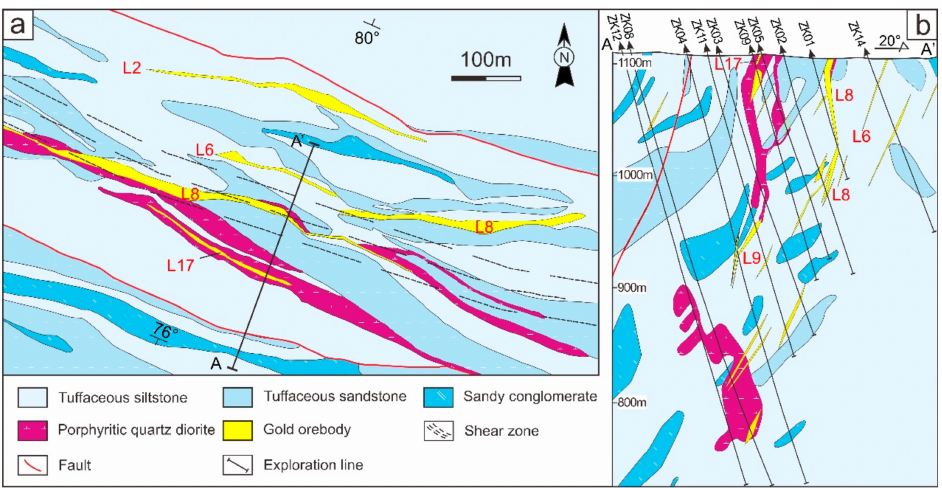
Figure 3. The distribution characteristics of orebodies in the Dunbasitao gold deposit (according to Liu et al. [35]). ( a ) Geological map of the area around the main orebody with the no. 0 exploration line noted. ( b ) Cross-section of the no. 0 exploration line, showing the relationships between strata, porphyritic quartz diorite, and